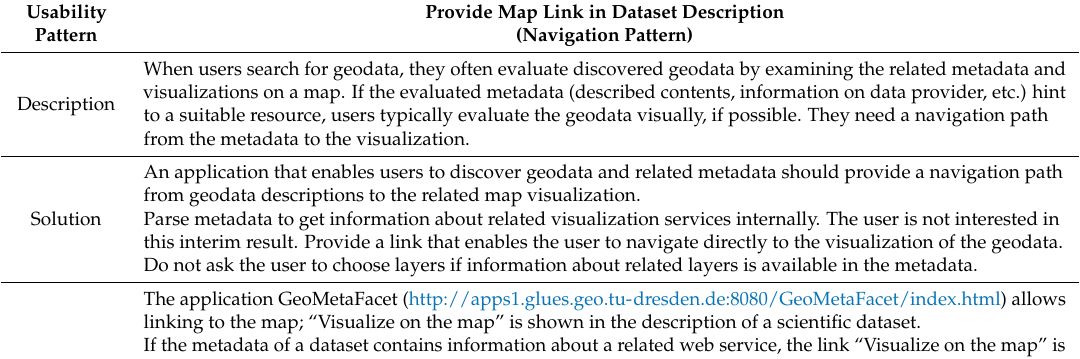
Table 7. Usability pattern Provide map link in dataset